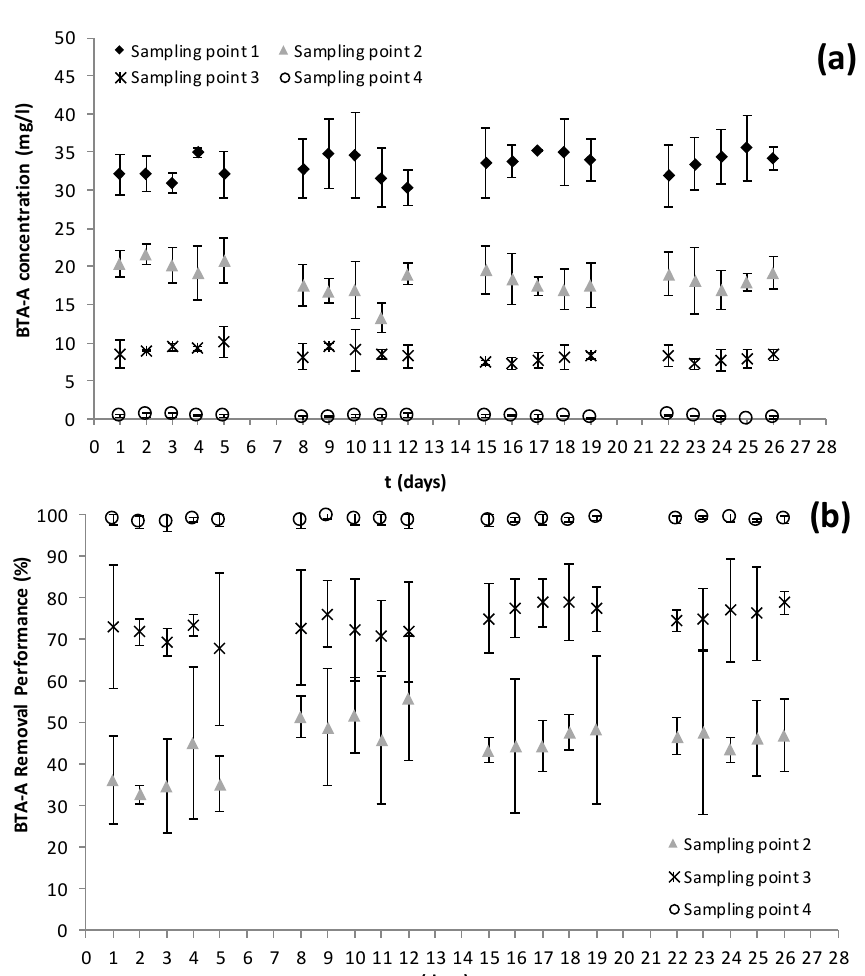
Figure 5. Results on ( a ) the benzotriazole based anticorrosive (BTA-A) concentration; and ( b ) cumulative BTA-A removal percentage at the different stages of the dairy wastewater treatment plant, namely at the sampling point 2.—after neutralization under CO 2 ; sampling point 3.—after O 2 injection; and sampling point 4.—after the DAF, which corresponds to the effluent of the plant being discharged to the municipal sewage treatment plant (outlet). Cumulative removal percentages were calculated respect the entering BTA-A concentration at the sampling point 1.—entrance of the plant (inlet). Note: Error bars stand for standard deviation values ( n = 3).